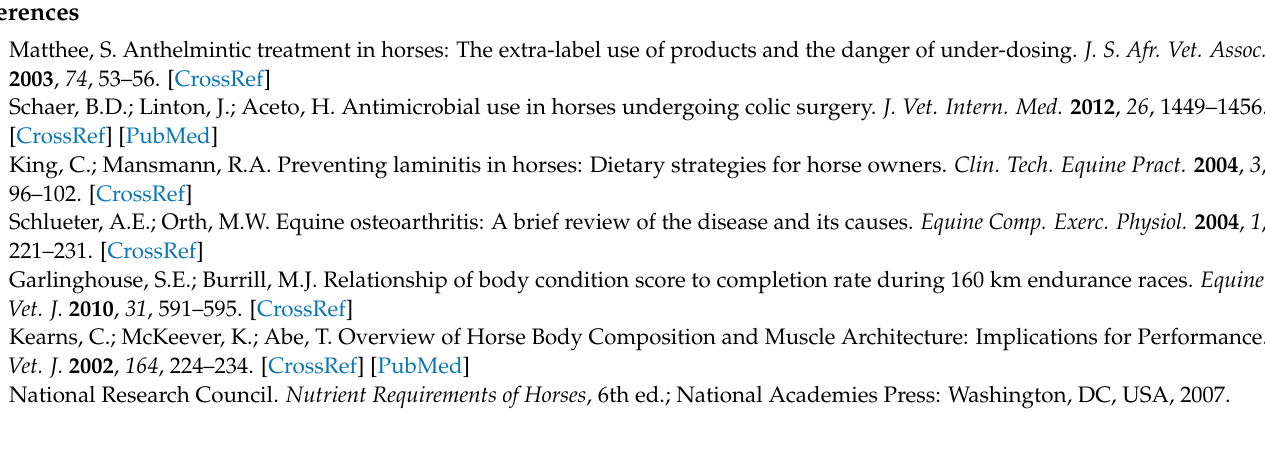
horse breeds represented in the date. Table S1: Details of the breeds and cross-breeds represented in the data and the number of horses within